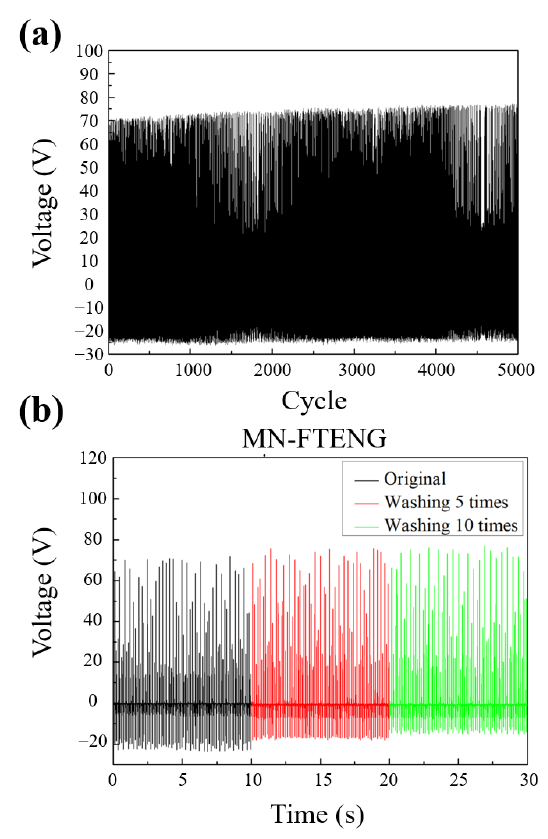
Figure 6. ( a ) The electrical performance of MN-FTENG is stable after 5000 cycles of beating test, and the inset is the enlarged waveform; ( b ) MN-FTENG has quite stable power generation performance in 0 times, 5 times and 10 times of cleaning